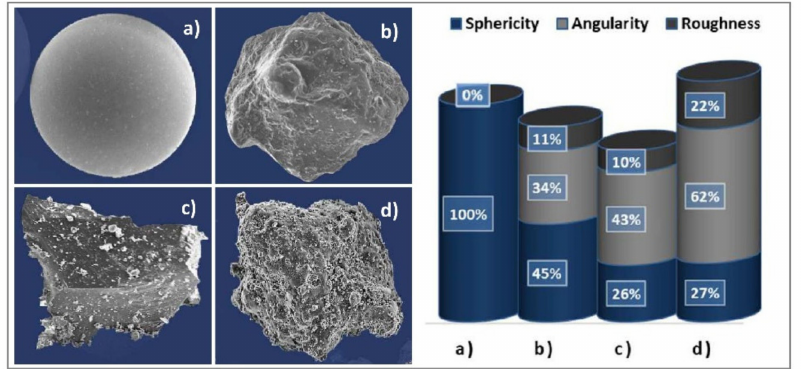
Figure 1. SEM images of 4 soil particles’ shapes: ( a ) glass microbeads (GM); ( b ) sandy silt from Krakowiany (SK); ( c ) sandy silt from Graniczna (SG); ( d ) fly ash